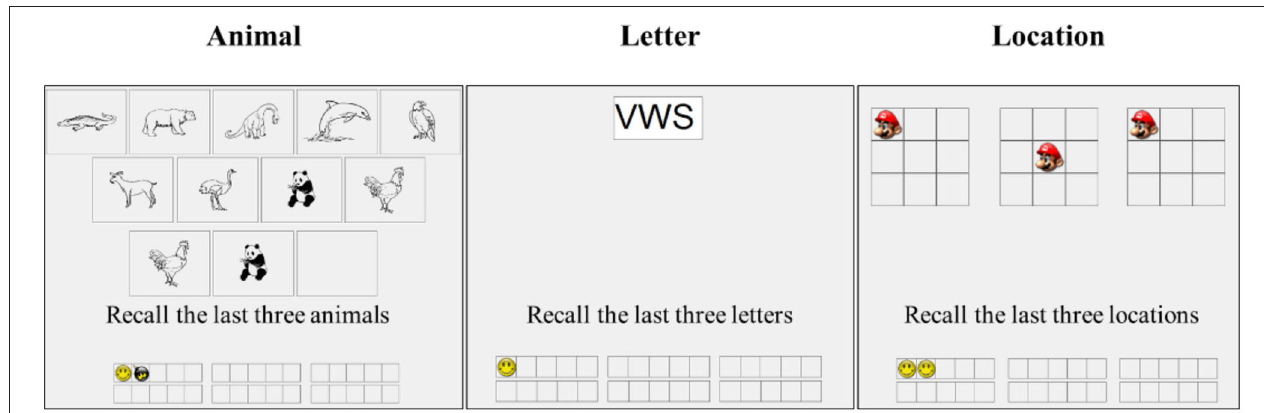
FIGURE 3 | Demonstration of three training